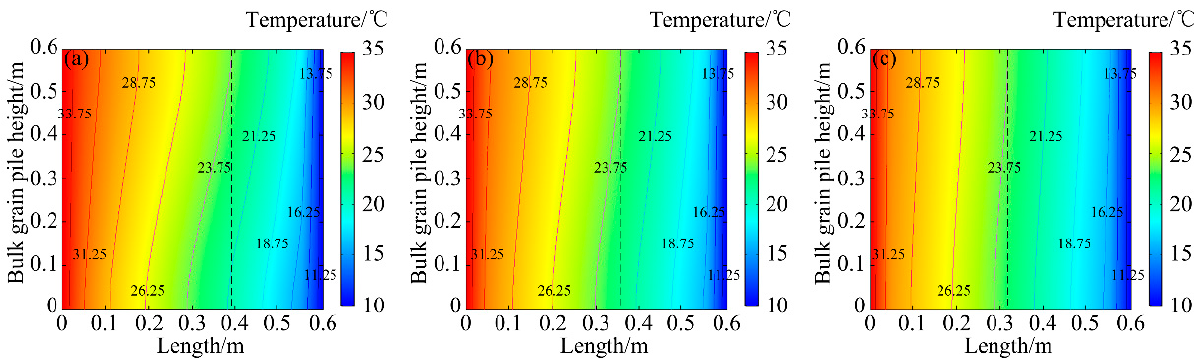
Figure 8. Temperature distribution of the middle plane of grain pile under different pressures: ( a ) 50 kPa; ( b ) 100 kPa; ( c ) 200 kPa.